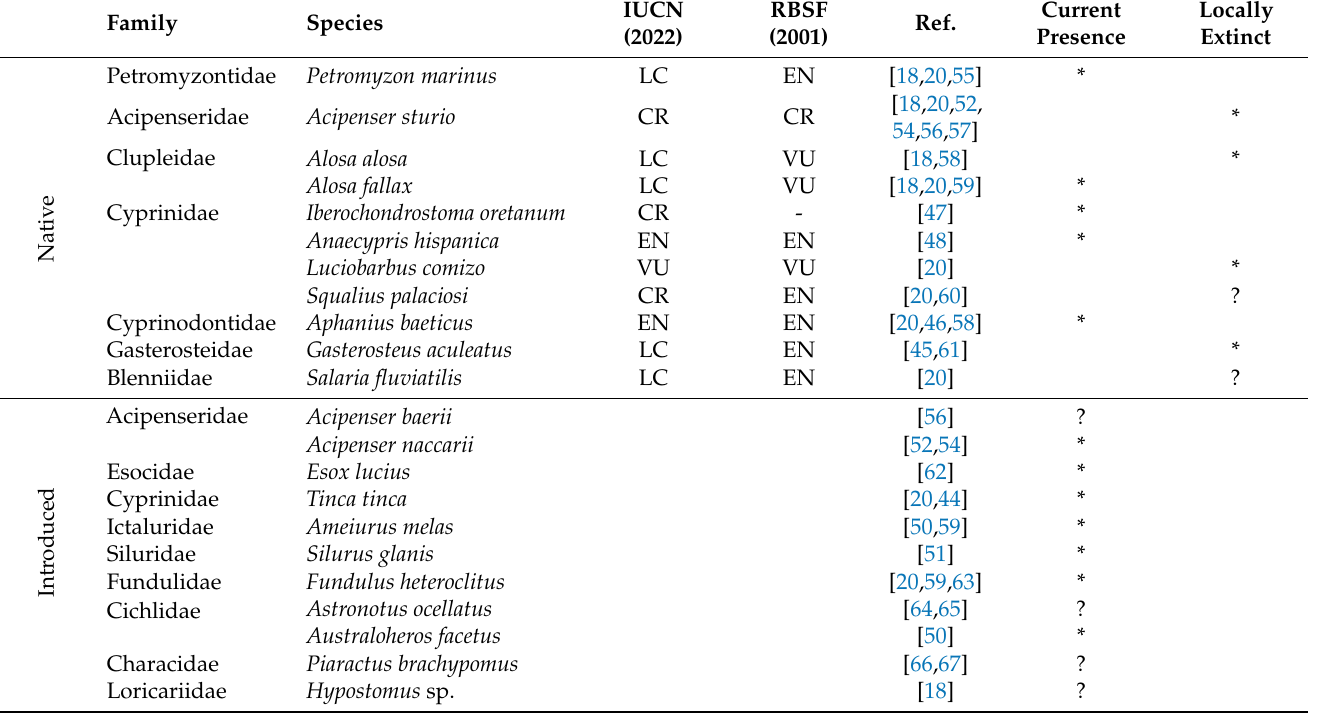
Table 4. List of native and exotic freshwater fishes detected during the bibliographic search. Threat categories are referred to IUCN Red List [10] and Red book of Spanish freshwater fish, RBSF [20].